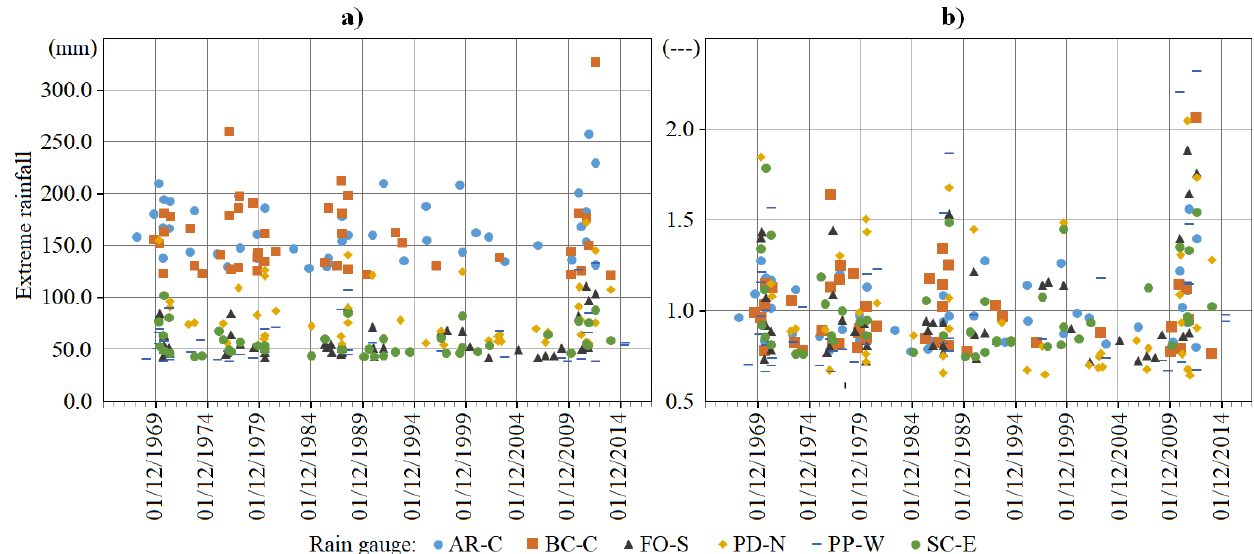
Figure 2. The winter (DJF) extreme daily rainfalls, i.e., the highest 45 rainfalls or 1% of the retrieved 4500 daily data at each rain gauge from 1967/1968 through 2016/2017, in absolute ( a ) and dimensionless ( b )